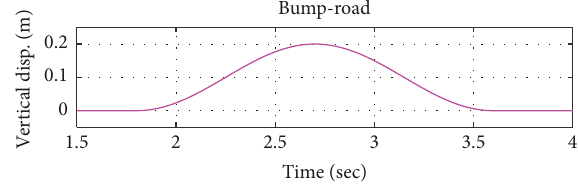
Figure 8: The bump-typed track profile is used to estimate the AT2FC.